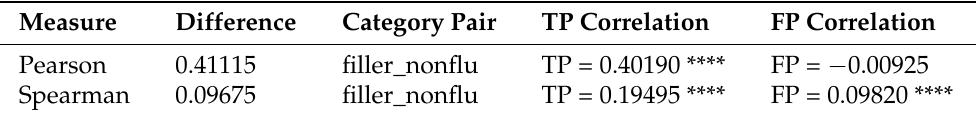
Table 38. Filler and Non-fluency in